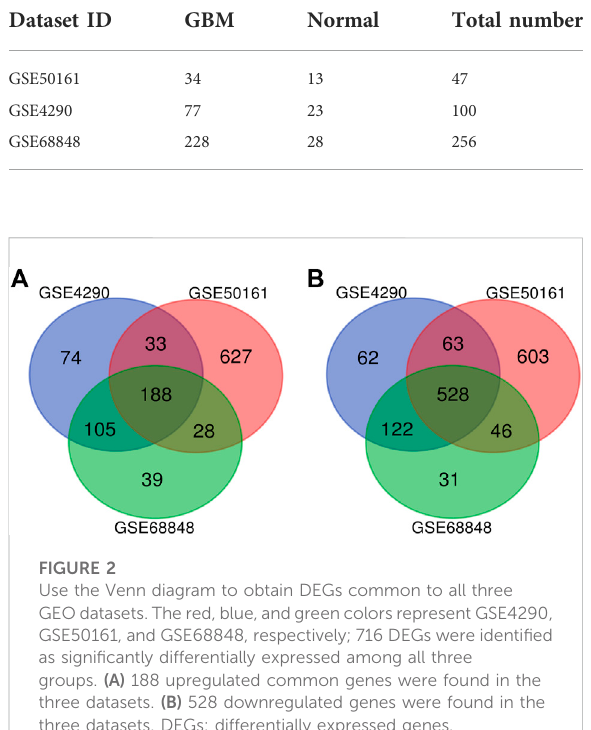
samples, GSE4290 contained 77 GBM and 23 normal samples, and GSE68848 contained 228 GBM and 28 normal samples (Table 1). Based on the cutoff criteria of p < 0.05 and | logFC| ≥ 2, a total of 2,116 DEGs were identi fi ed from GSE50161,